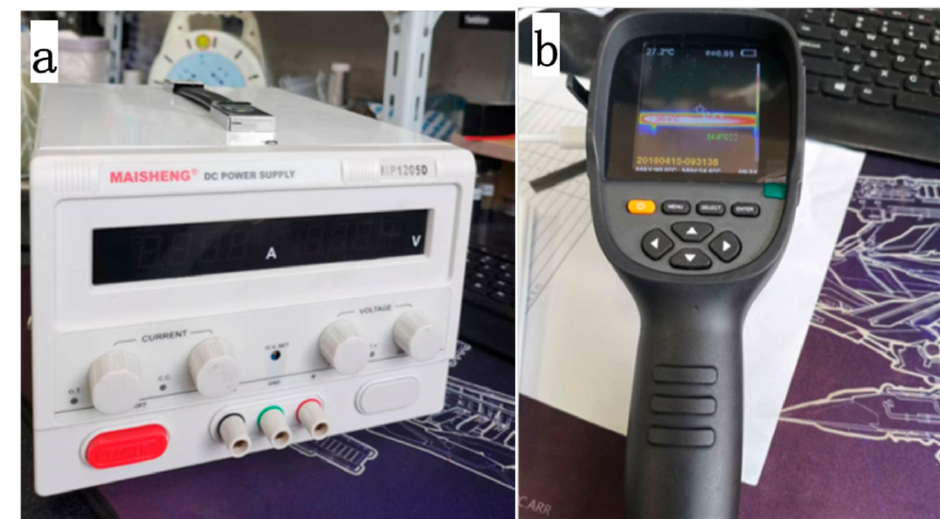
Figure 2. ( a ) The DC power supply, and ( b ) the infrared thermal imager.